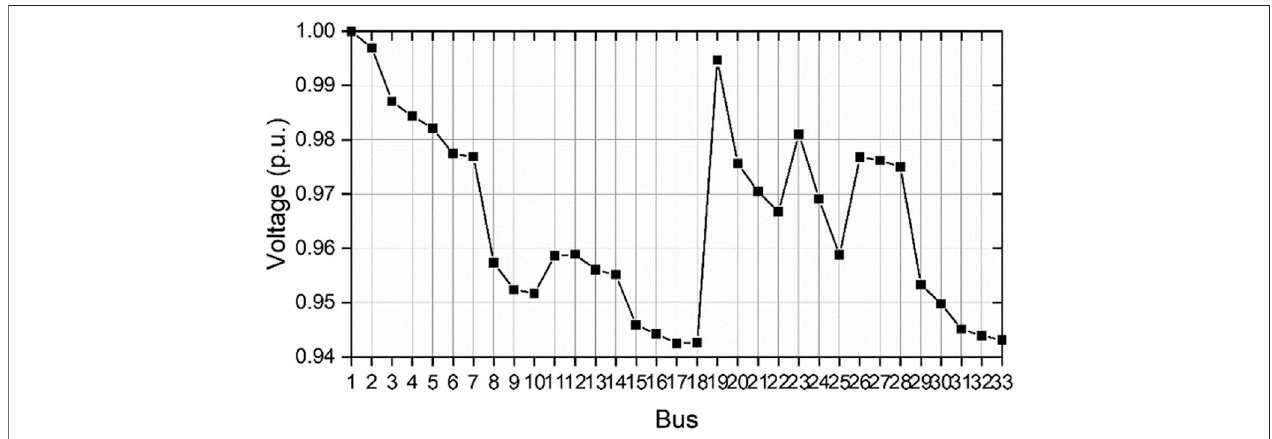
FIGURE 11 | Bus voltage of the distribution